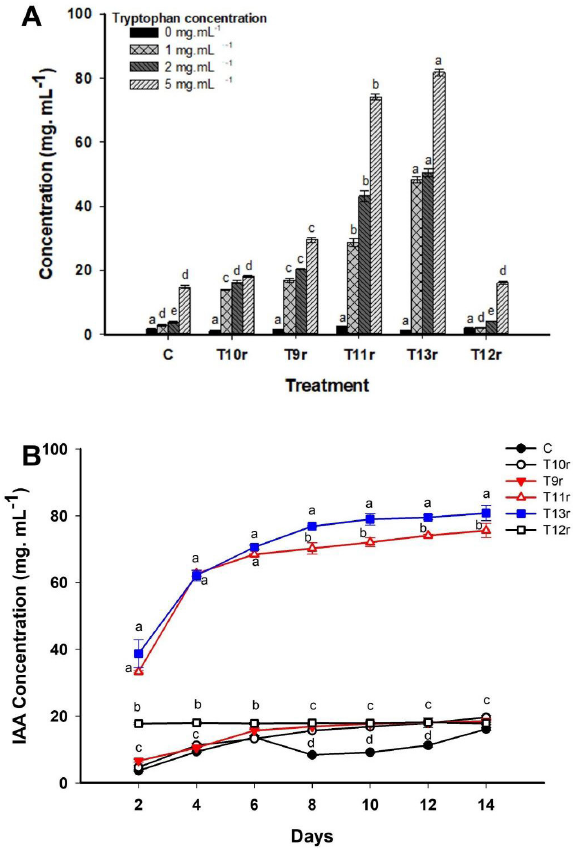
Figure 3: Indole-3-acetic acid (IAA) production by the most endophytic bacterial strains isolated from T. vulgaris . A is denotes the qualitative IAA assay at different tryptophan concentrations (0, 1, 2, and 5 mg ml –1 ), B is denoted the quantitative IAA assay in broth media amended with 5 mg ml –1 tryptophan at various time courses (2 to 14 days). Values with different letters are significantly different ( p ≤ 0.05), values are means ± SE ( n =